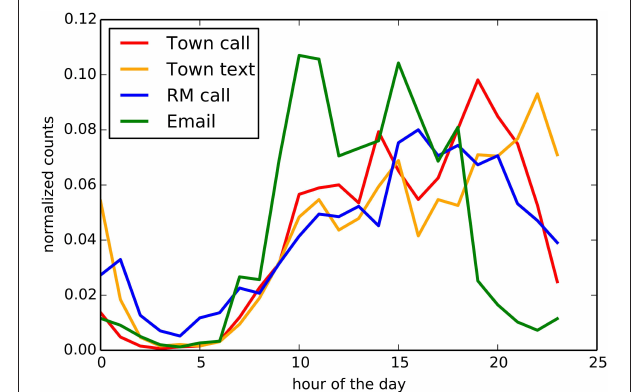
FIGURE 1 | Number of events per hour for each day of week in our datasets. This curve has been aggregated over the entire 8-week period. From top to bottom: calls in Reality Mining, calls and texts in small town, and emails. We observe strong diurnal patterns in all datasets; for the small town datasets there are also differences between calls and and texts activity. The email dataset shows decreased activity during weekends.